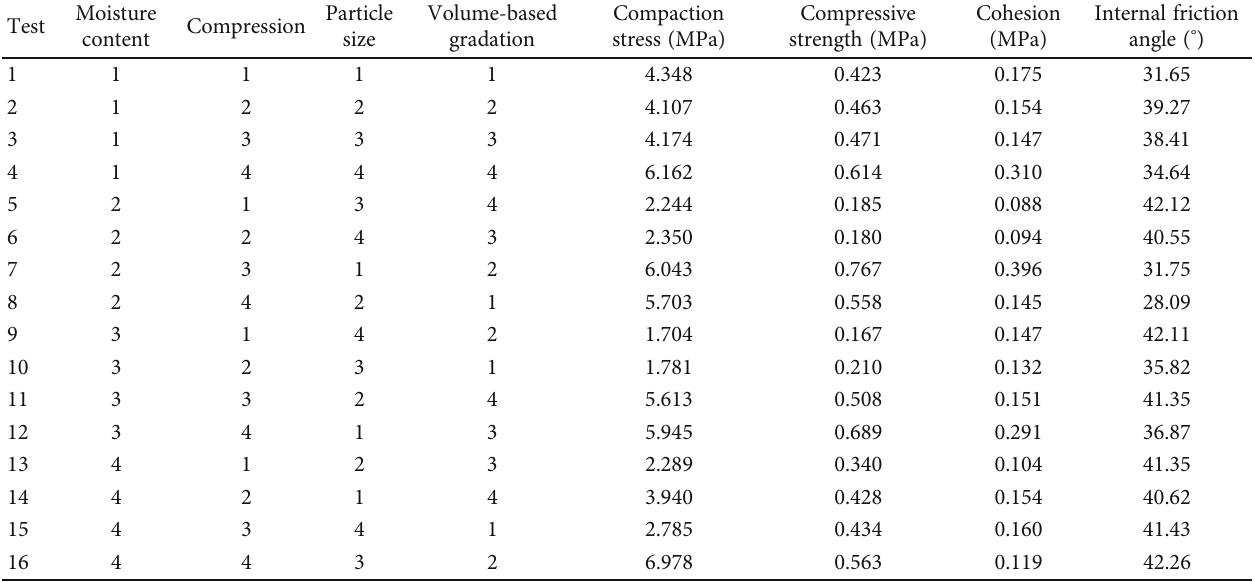
Table 3: Test results.